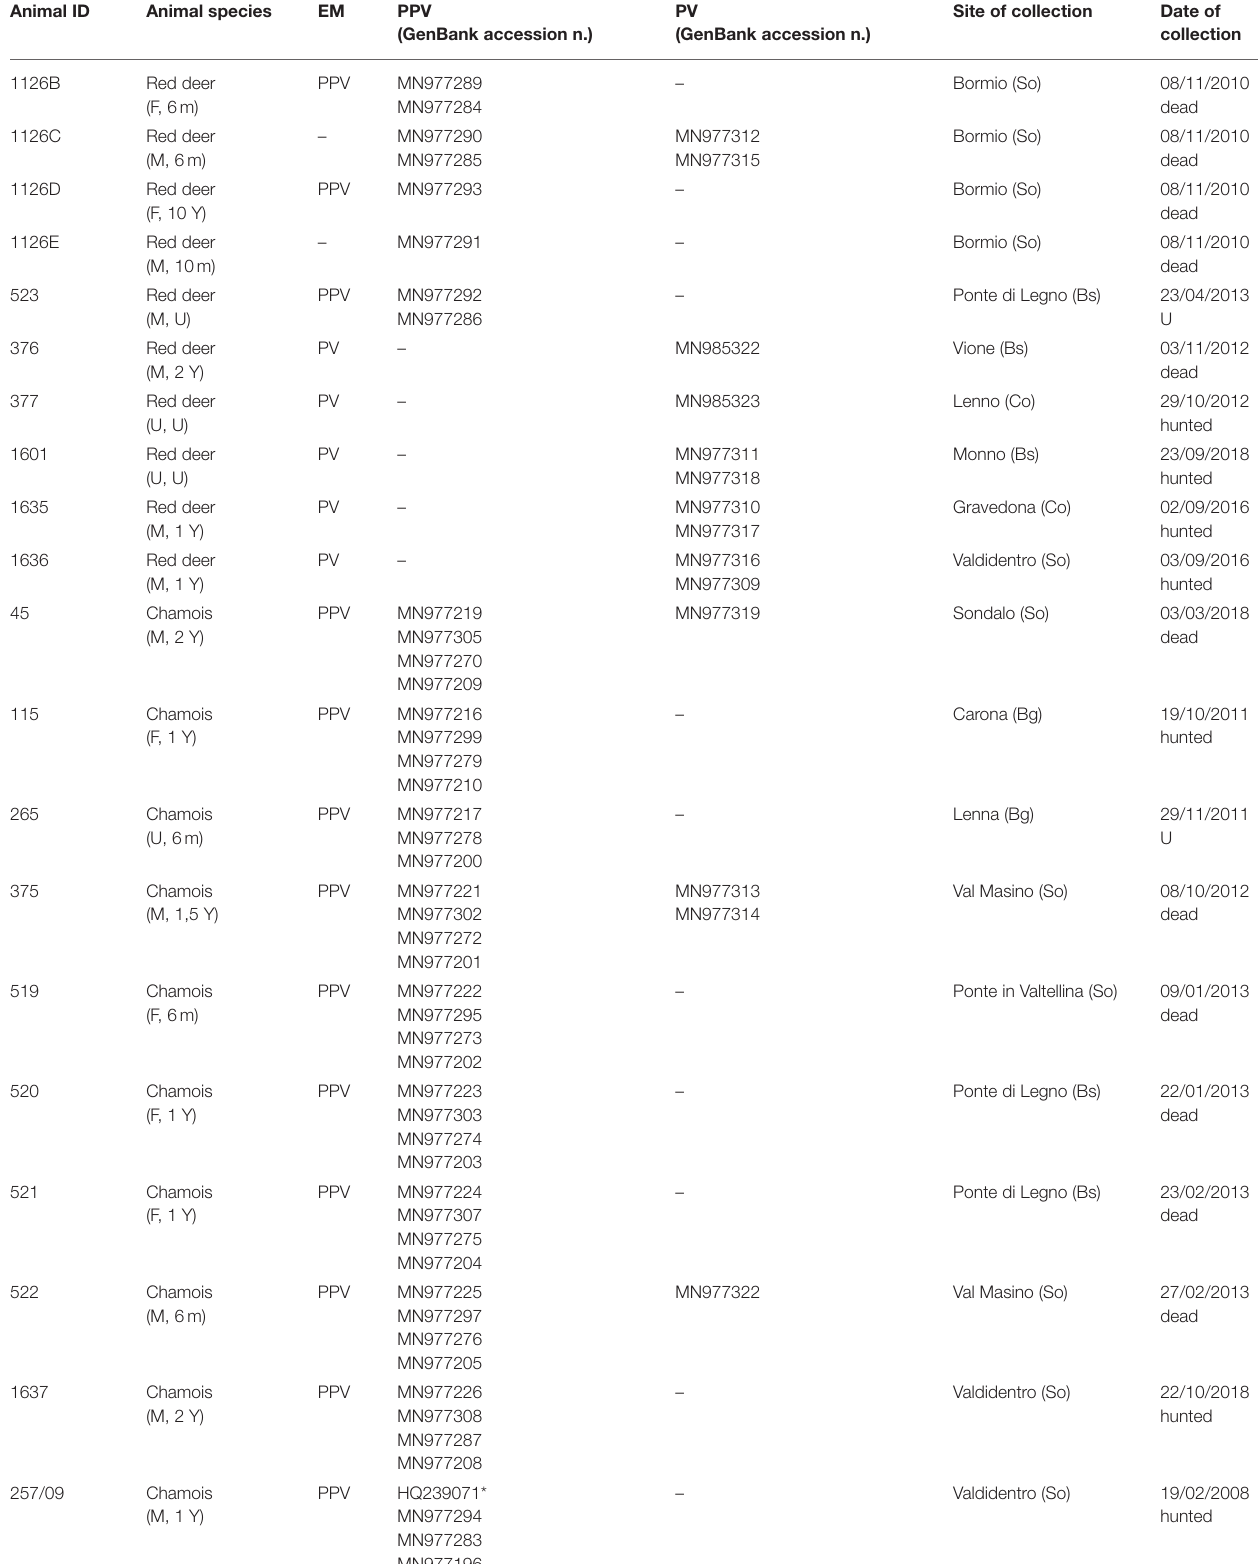
TABLE 1 | List of examined cases. Animal ID Animal